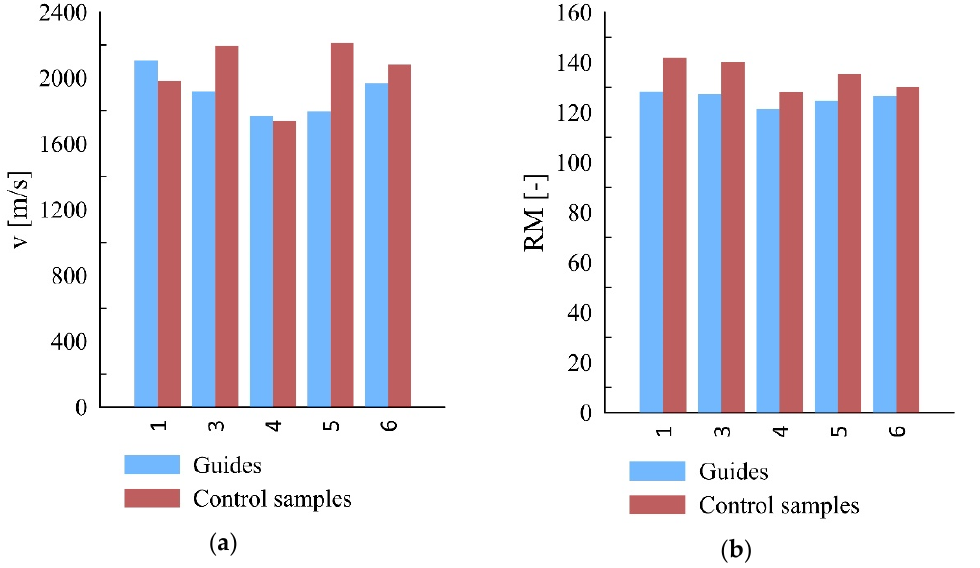
Figure 8. Comparison of ultrasonic and drill resistance test of guide and reference samples; ( a ) ultrasonic tests, ( b ) drill resistance tests.